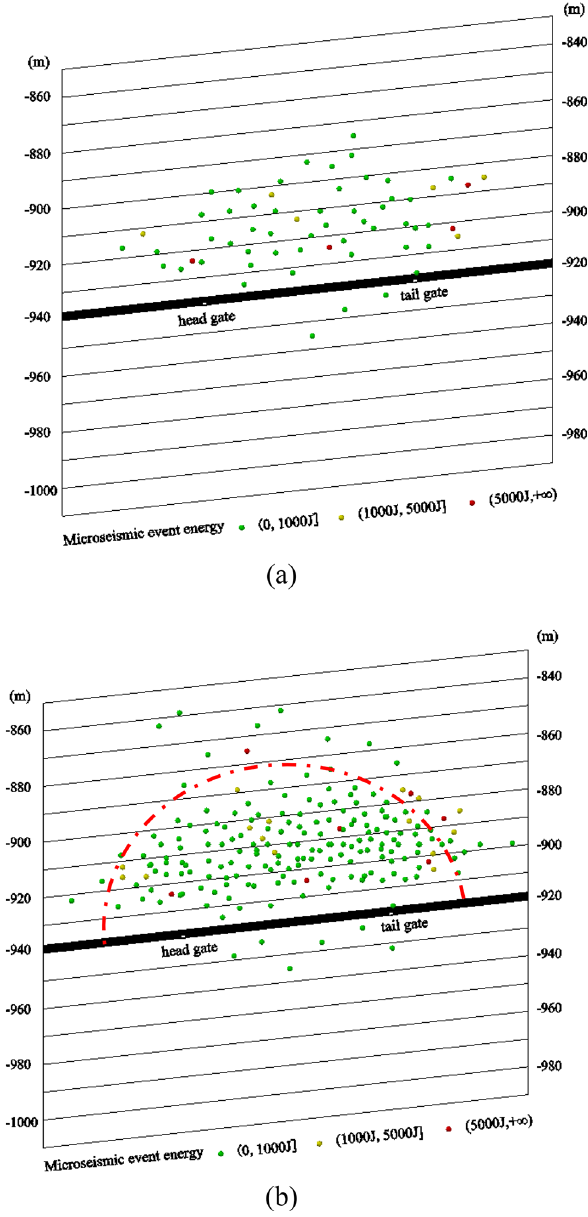
Figure 10. Vertical distributions of microseismic events ( a ) before and ( b ) after disturbance